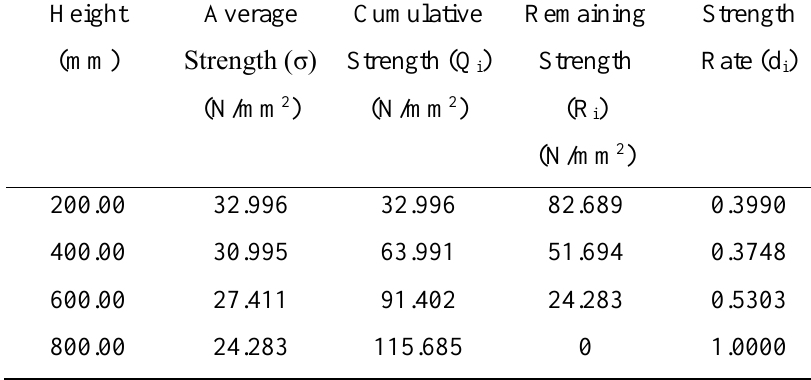
Fig. 7. Reliability of Iroko timber. Strength Analysis of Mahogany